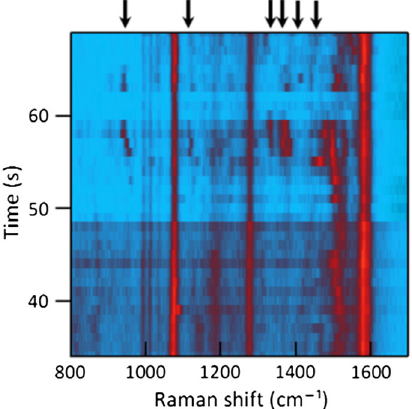
FIG. 9. SERS time series from a single 80-nm gold nanoparticle on mirror for 300 μ W = μ m 2 CW 633-nm laser excitation. Strong additional Raman lines (vertical arrows) arise and disappear in time, existing alongside the constant main BPT Raman